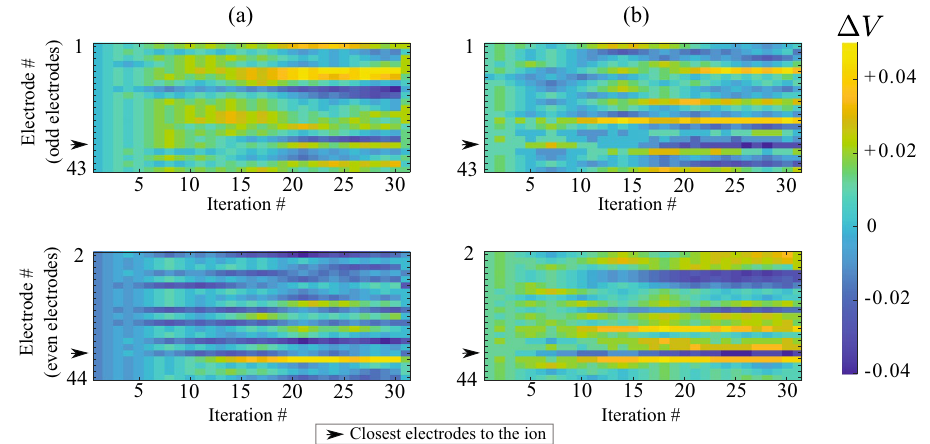
Figure 3. Voltage deviation from the original starting point during optimization with ADAM. ( a ) uncharged trap (“Gradient descent optimizer” section). ( b ) During UV charging (“Testing under poor trap conditions”). Top graphs show odd electrode numbers corresponding to top DC electrodes in Fig. 1b and the bottom graphs show the even electrode numbers. The values were determined by subtracting the voltage at each iteration by the starting voltage (cid:31) V = V n − V 0 . Changes can be seen in almost all the electrodes of the